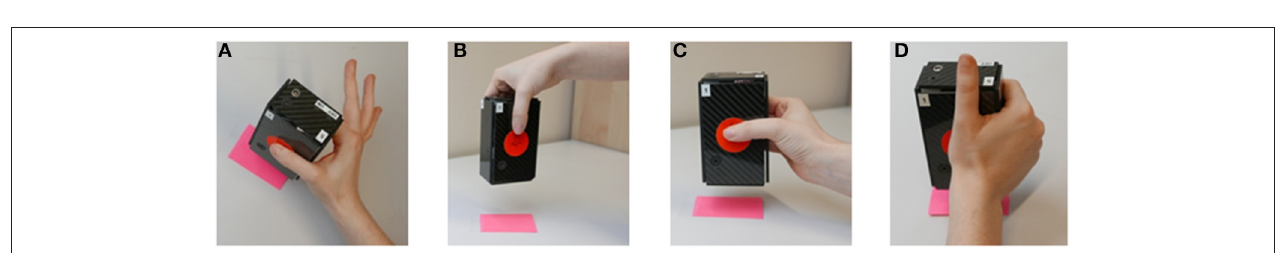
Fugl-Meyer upper limb evaluation (sensory/motor subscores)